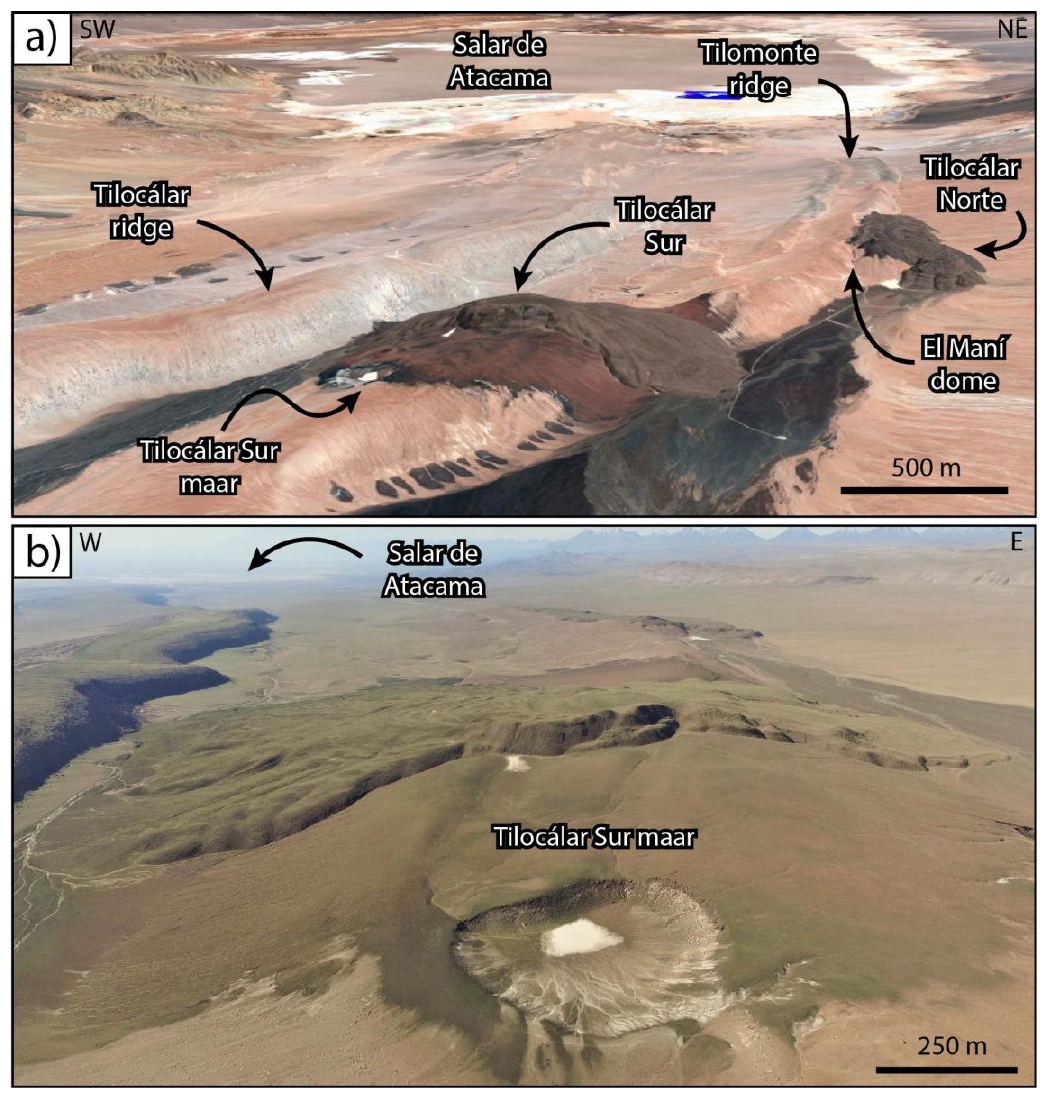
Figure 3. Tilocálar Sur maar. ( a ) Satellite image taken from Google Earth TM , showing the location of the Salar de Atacama basin and the morphology of the surface. ( b ) Aerial view of the Tilocálar Sur maar.